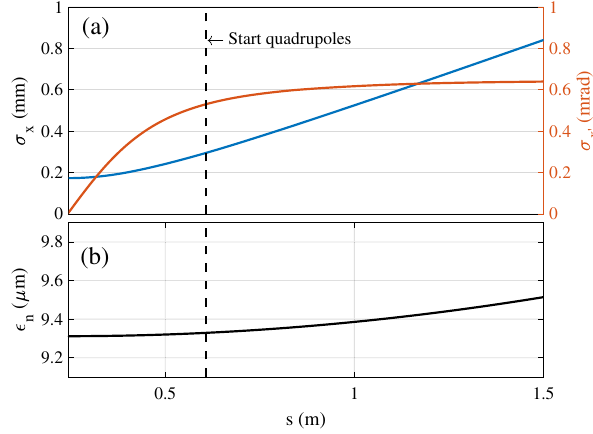
FIG. 10. (a) Fit result of measured waist of witness-beam and corresponding s -dependent divergence. (b) Emittance-growth in the drift-space downstream of the plasma